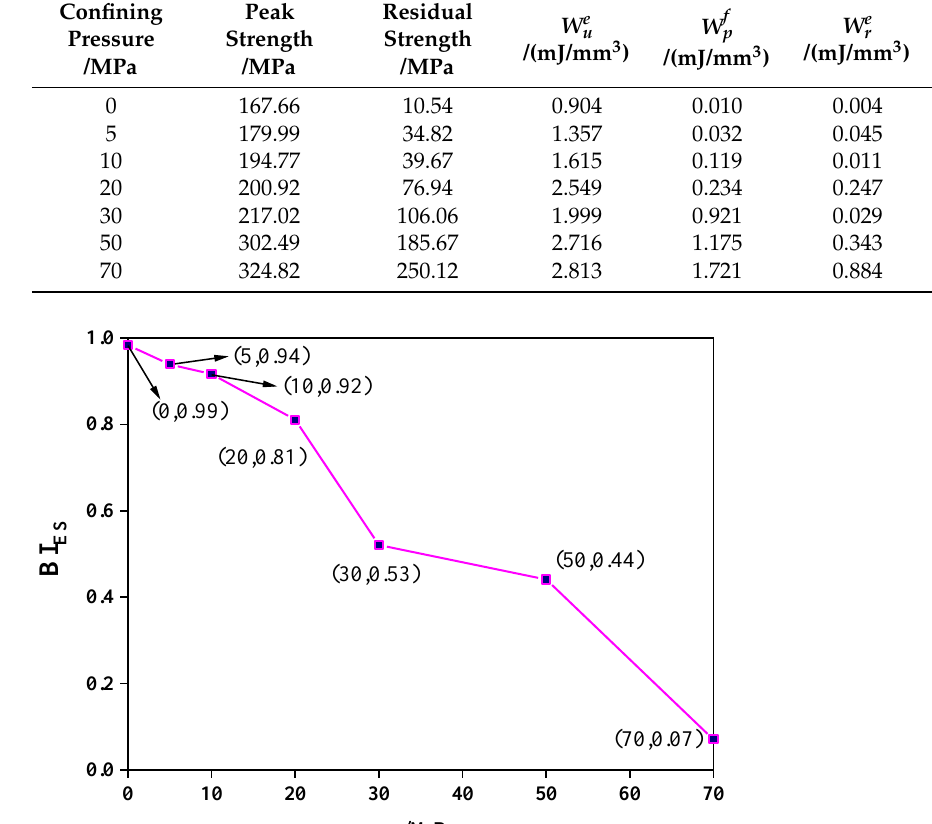
Figure 6. Relationship between BI ES of the shale samples and the corresponding confining pres- sures.